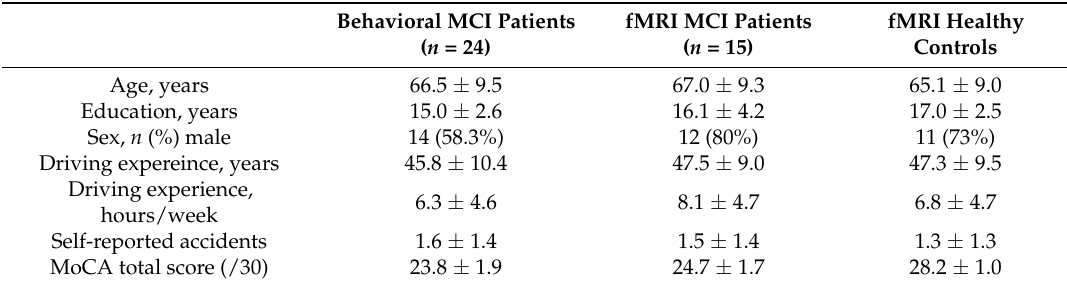
Table 3. Demographic information of patients with MCI who completed the behavioral session ( n = 24) and the fMRI session ( n =